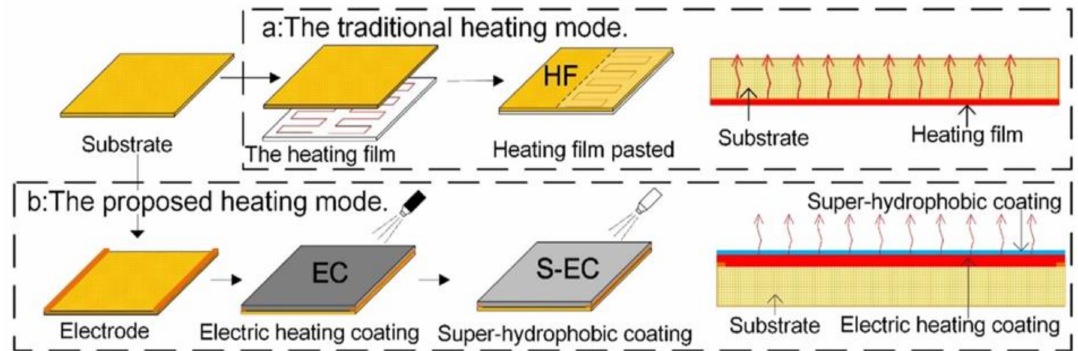
Figure 5. Schematic of the fabrication process and the heating mode of the samples ( a ) H.F. and ( b ) S-EC. (Reported from [64] with permission; Copyright 2018 Elsevier